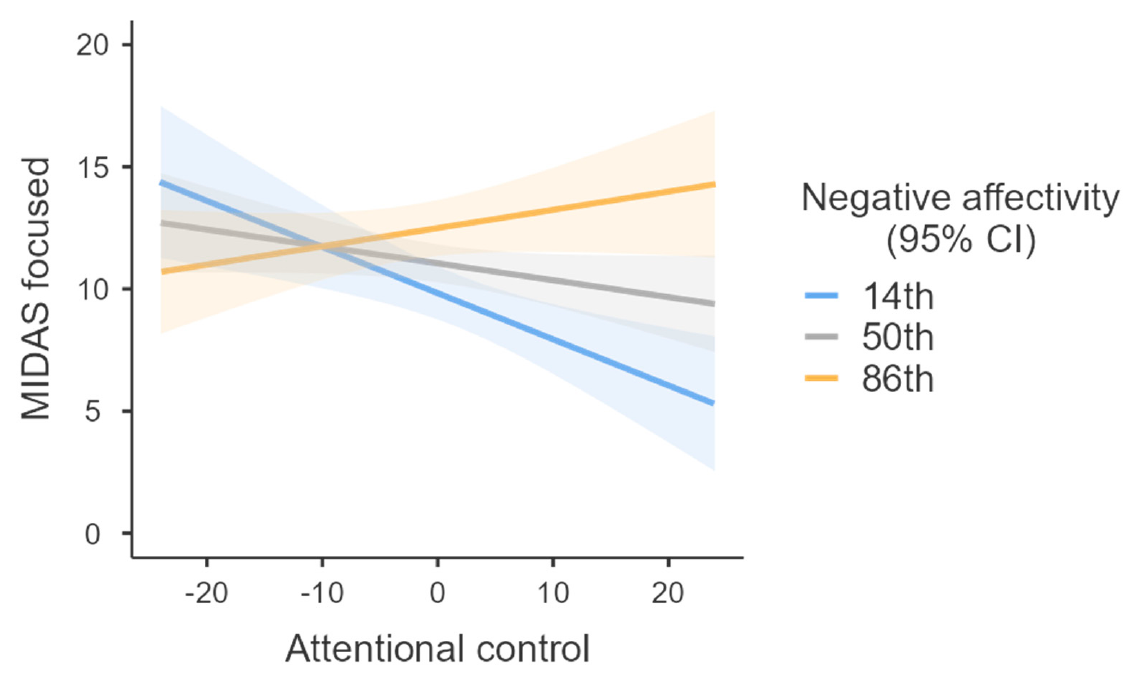
Figure 1. Relationship between attentional control and focused skin picking at different levels of negative affectivity.